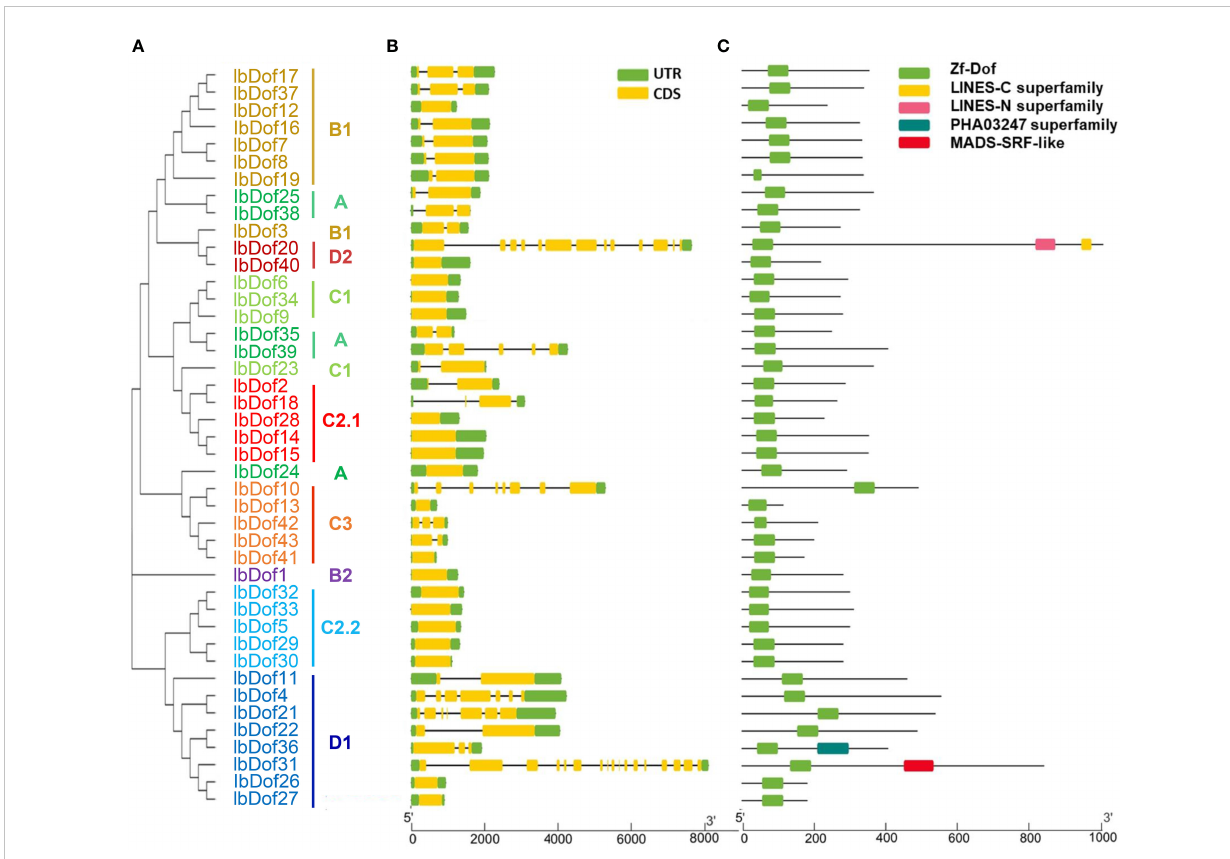
FIGURE 3 Phylogenetic relationships, gene structures and conserved domain distributions of 43 IbDof TFs in sweetpotato. (A) The phylogenetic tree of 43 IbDofs was constructed by MEGA X based on the consistent parameters used in Figure 2. (B) Gene structures of 43 IbDof genes. Exons and UTR are marked using yellow and green bars, respectively, black lines indicate introns. (C) Distributions of conserved domains detected by CD-search in the IbDof members. The colorful boxes present different conserved domains. The length of IbDofs can be estimated by the scale at the